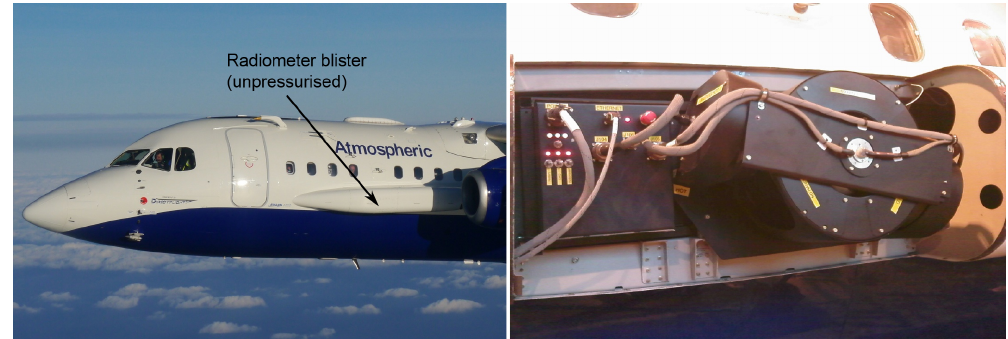
Figure 1. The location of the radiometer blister on the FAAM BAe-146 aircraft, and the ISMAR instrument installed in the blister with the cover